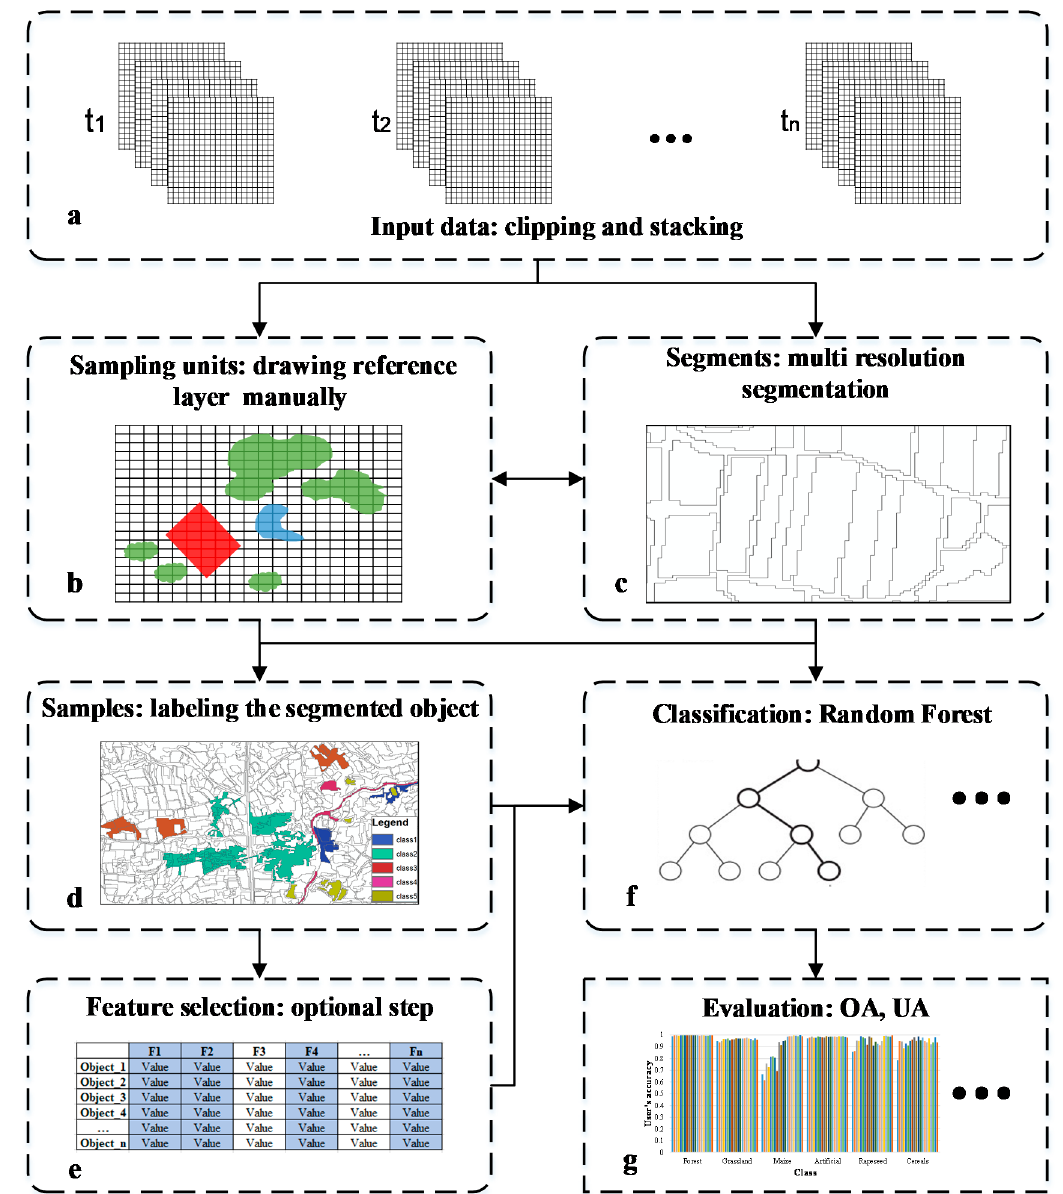
Figure 2. The object-based satellite image time-series (OB-SITS) workflow. ( a ) The optical